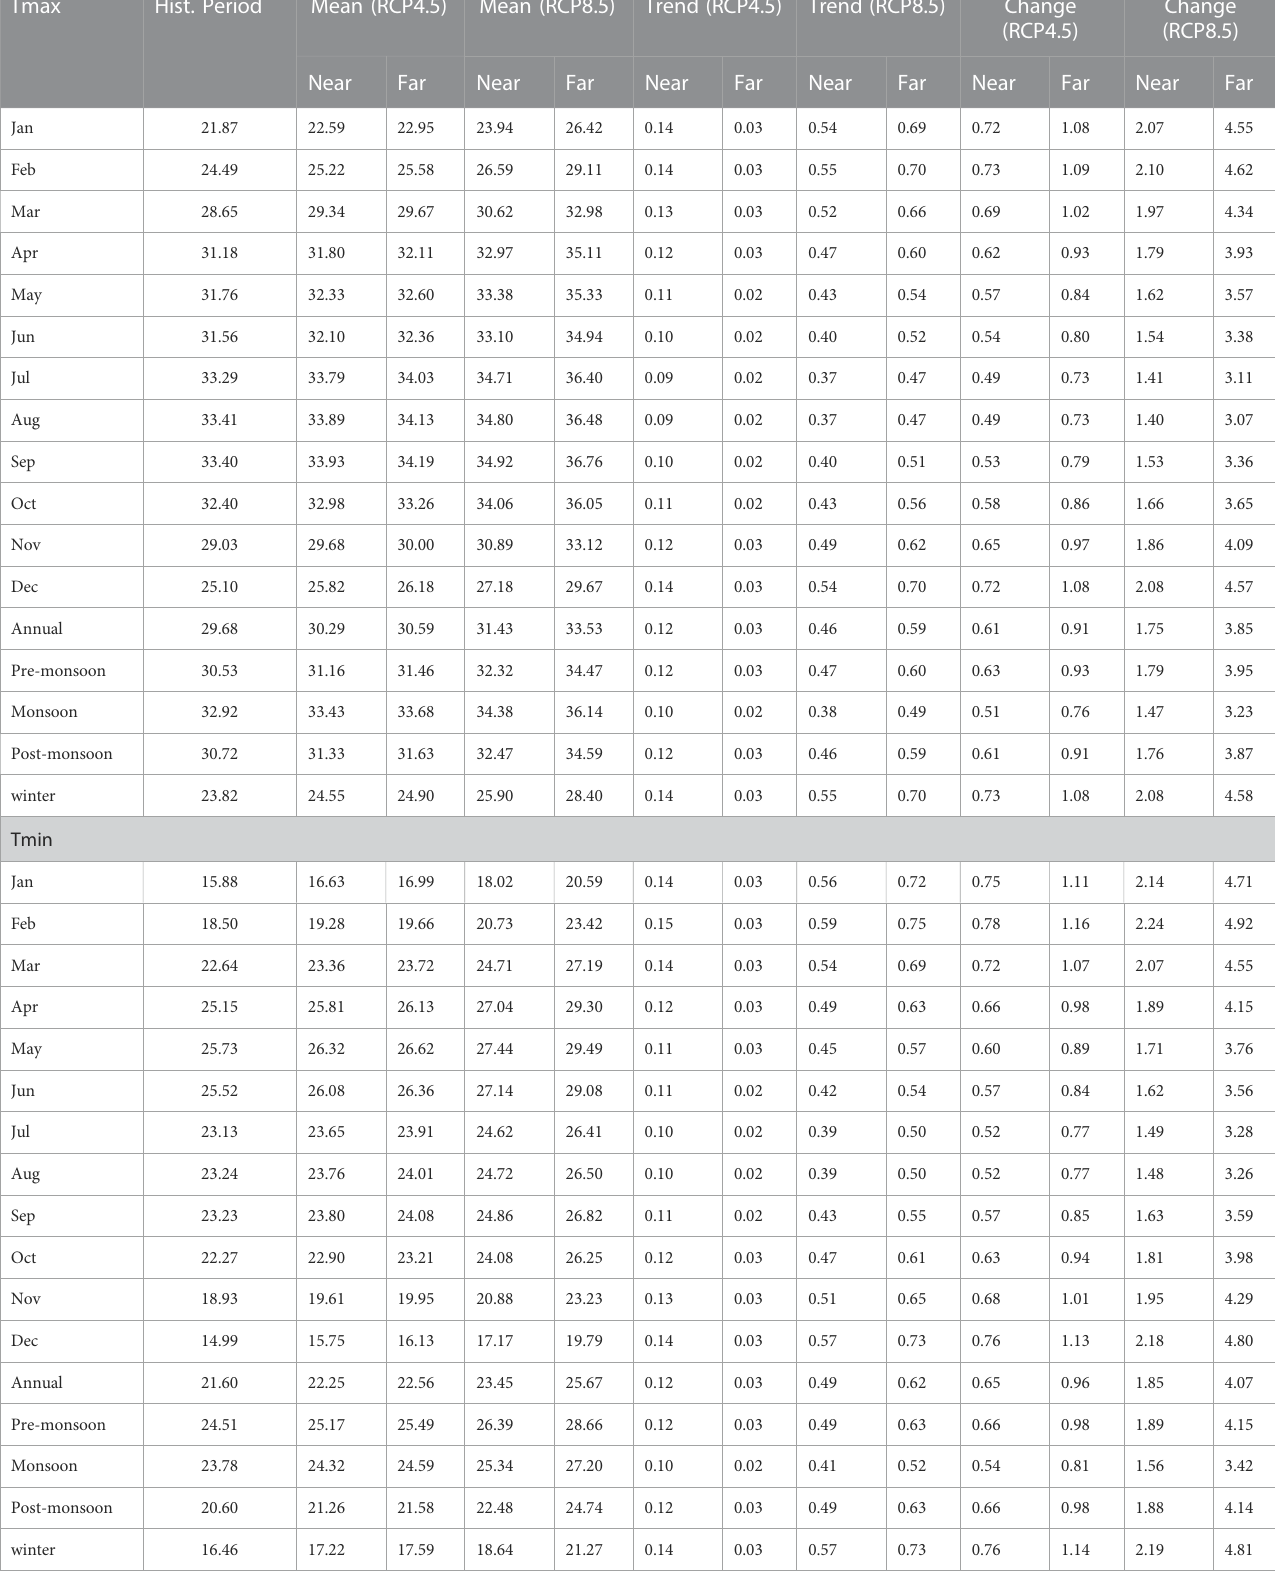
Change (RCP4.5) (RCP8.5)